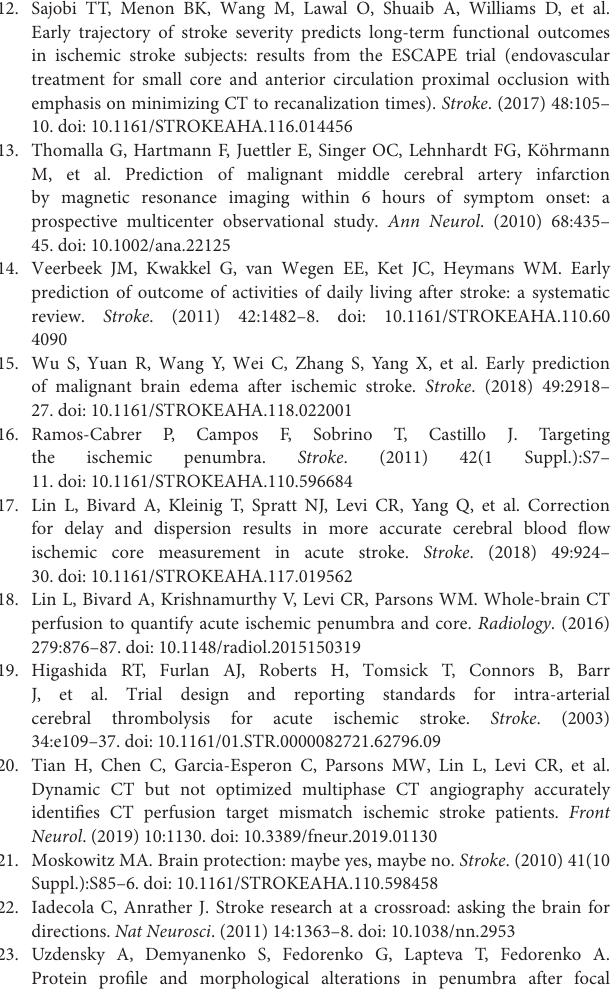
Supplementary Figure 1 | Comparison of net water uptake (NWU) with poor collateral and good collateral